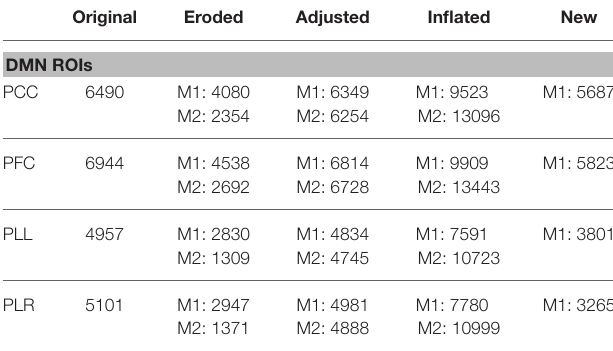
TABLE 2 | Size of masks (# of voxels) used to test reproducibility of node identification.